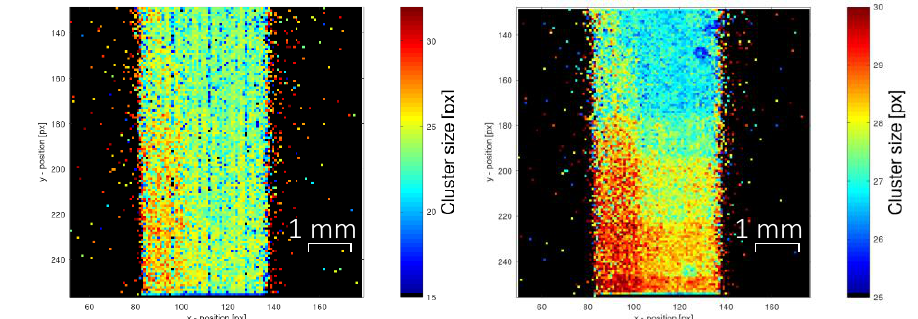
Fig. 6. Proton radiographies produced from non-filtered i.e., all data (left) and filtered data (right). The sample E is imaged with 2.9 MeV protons. The right filtered image is made from events selected in the following range: Deposited energy from 0.8 to 3.6 MeV, cluster area greater than 10 px and cluster energy height greater than 300 keV. Radiographies shown in spatial bin of one detector pixel i.e., 55 µm.